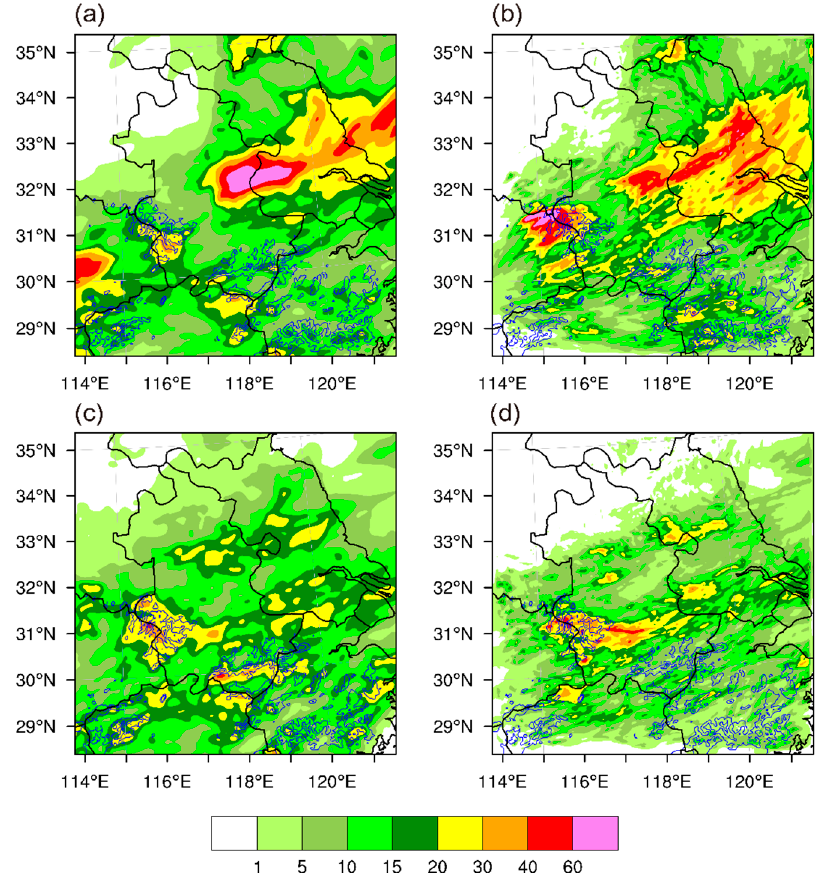
Figure 3. Spatial distributions of 12 h accumulated precipitation (mm) averaged from ( a , c ) the true state and ( b , d ) the control forecasts over lead times of 0–12 h for ( a , b ) SF events and ( c , d ) WF events.